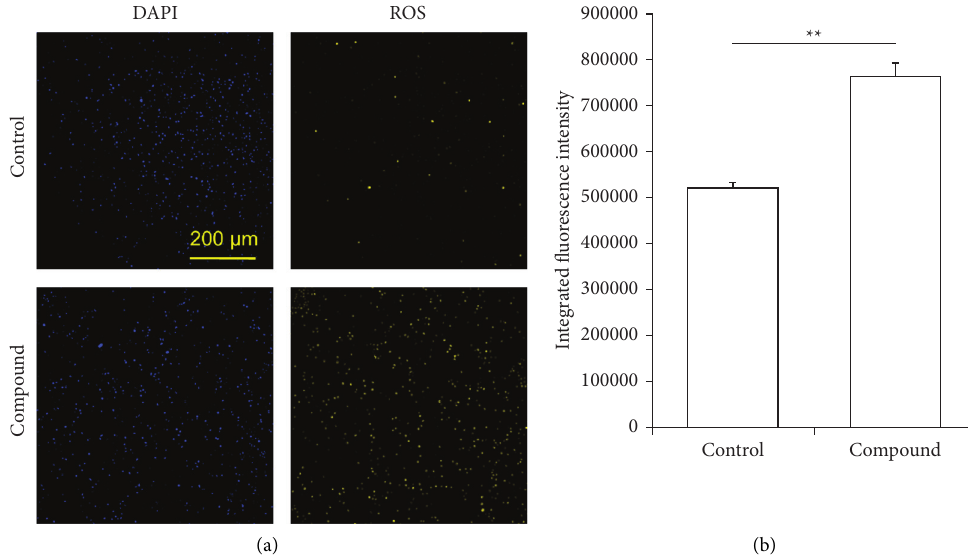
Figure 4: ROS production in the K562 ALDH(+) cells. (a) Representative images of the ROS status in K562 ALDH(+) cancer cells with or without 1 μ M compound exposure for 24h. (b) Integrated fluorescence intensity of the ROS signals in K562 ALDH(+) cancer cells with or without 1 μ M compound exposure for